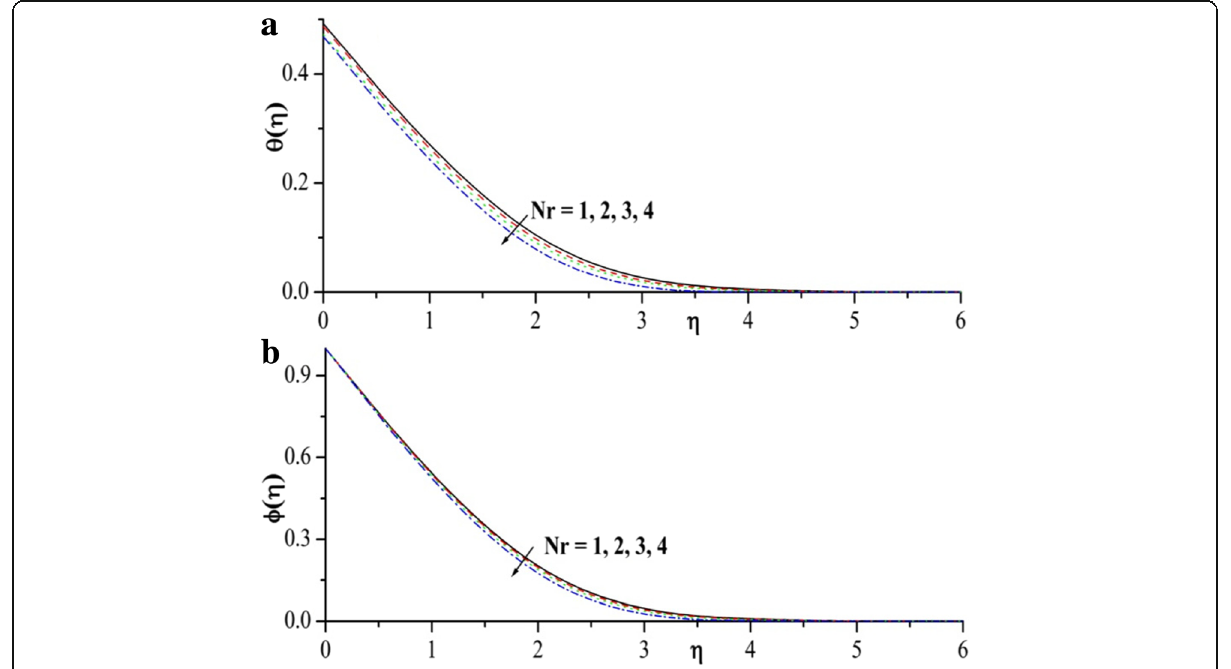
Fig. 11 a Temperature and b nanoparticle concentration profiles for variable values of